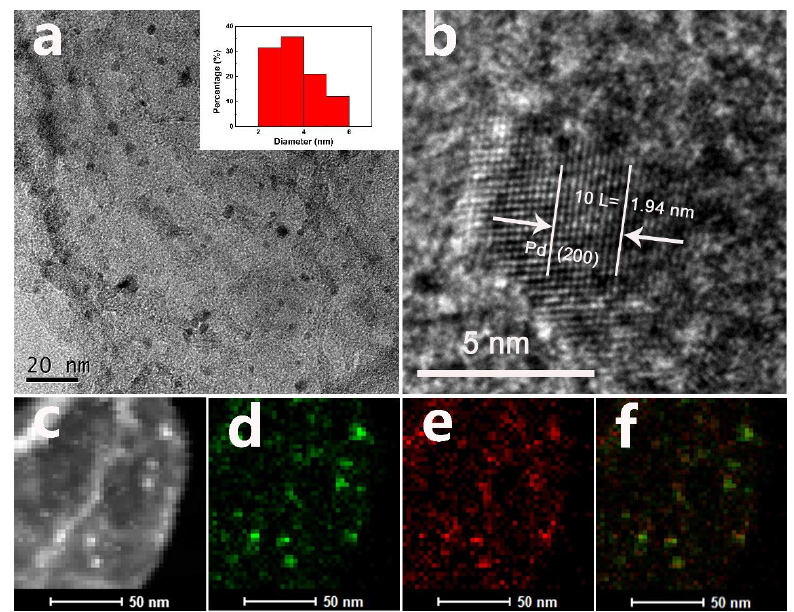
Figure 1. Representative ( a ) TEM image (inset is the size distribution histogram) and ( b ) high resolution (HR-TEM) image of Pd 50 Ru 50 /CNs. ( c ) Black field-TEM image of Pd 50 Ru 50 /CNs and energy dispersive X-ray spectroscopic (EDS) elemental mapping of ( d ) Pd, ( e ) Ru, and ( f ) Pd plus Ru elements in the Pd 50 Ru 50 /CNs.